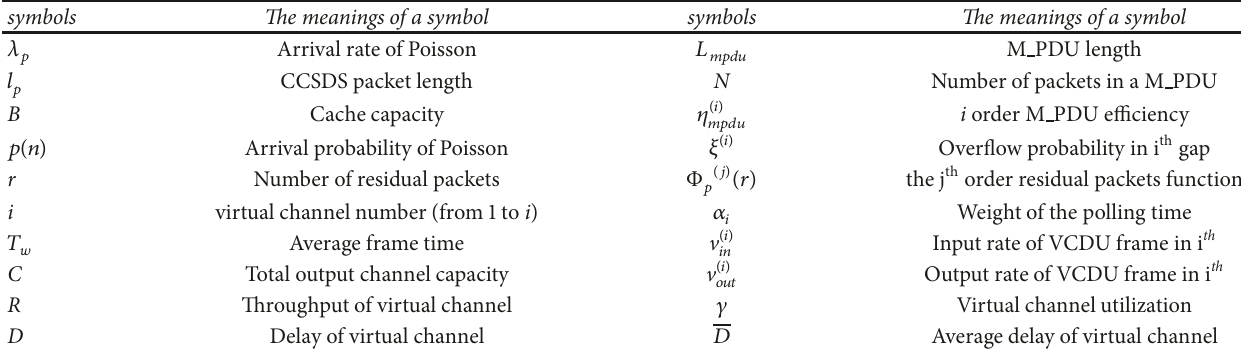
Table 1: the table of